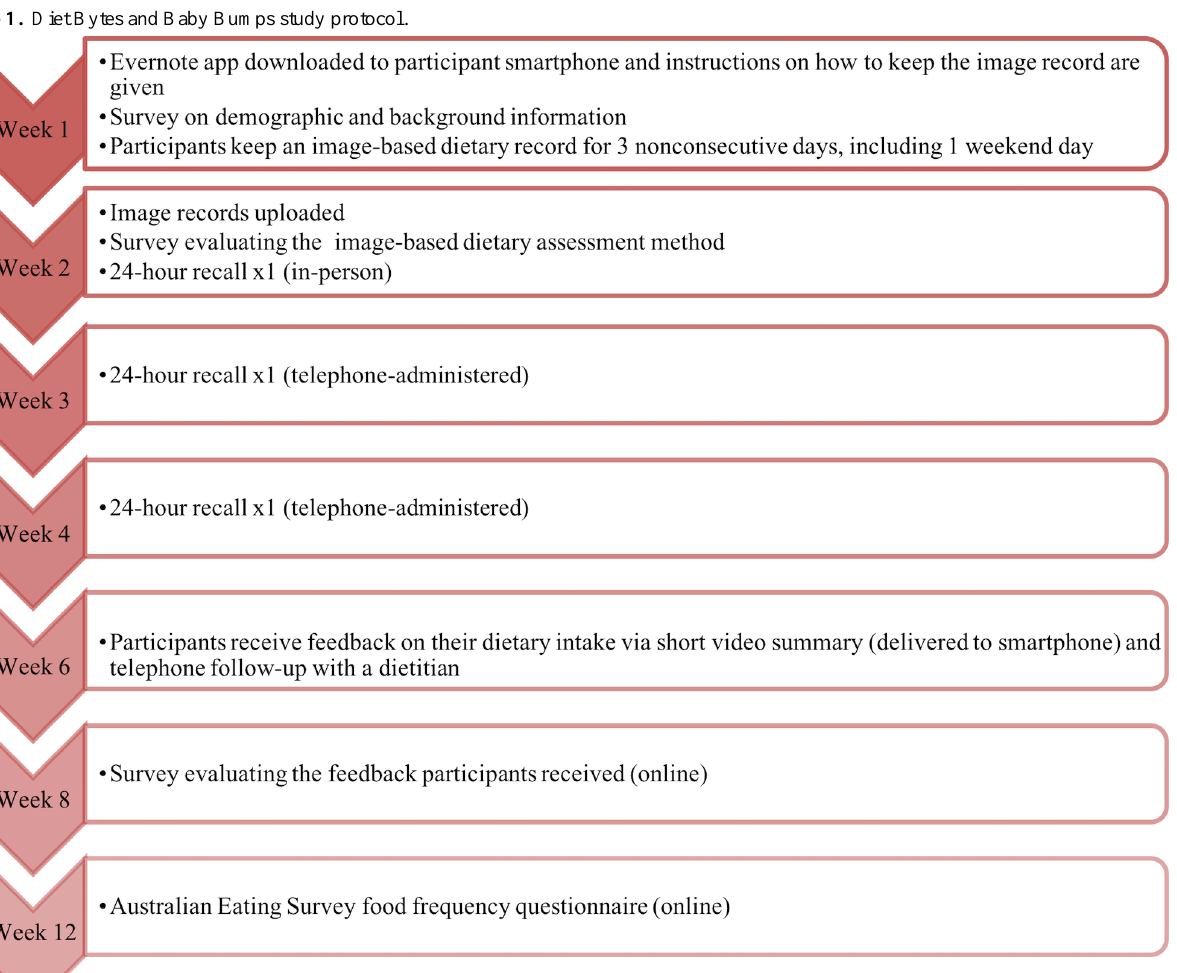
Figure 1. Diet Bytes and Baby Bumps study